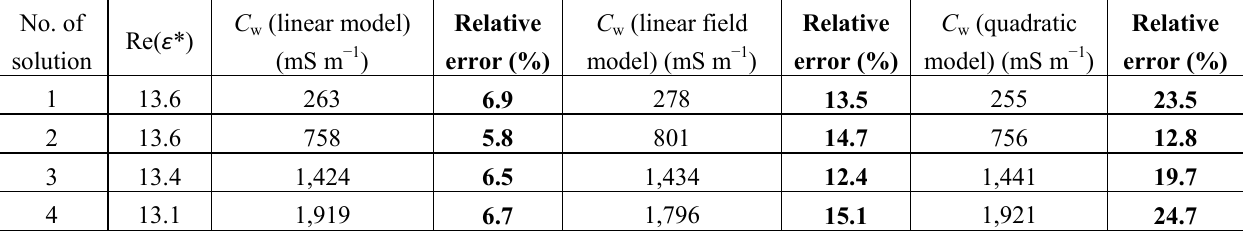
Table 3. Conductivities of water content (cid:1829) calculated from linear, linear field and (cid:3050) quadratic salinity index models, with respective errors, for four moistening solutions, for samples of loess with similar values of the real part of the dielectric